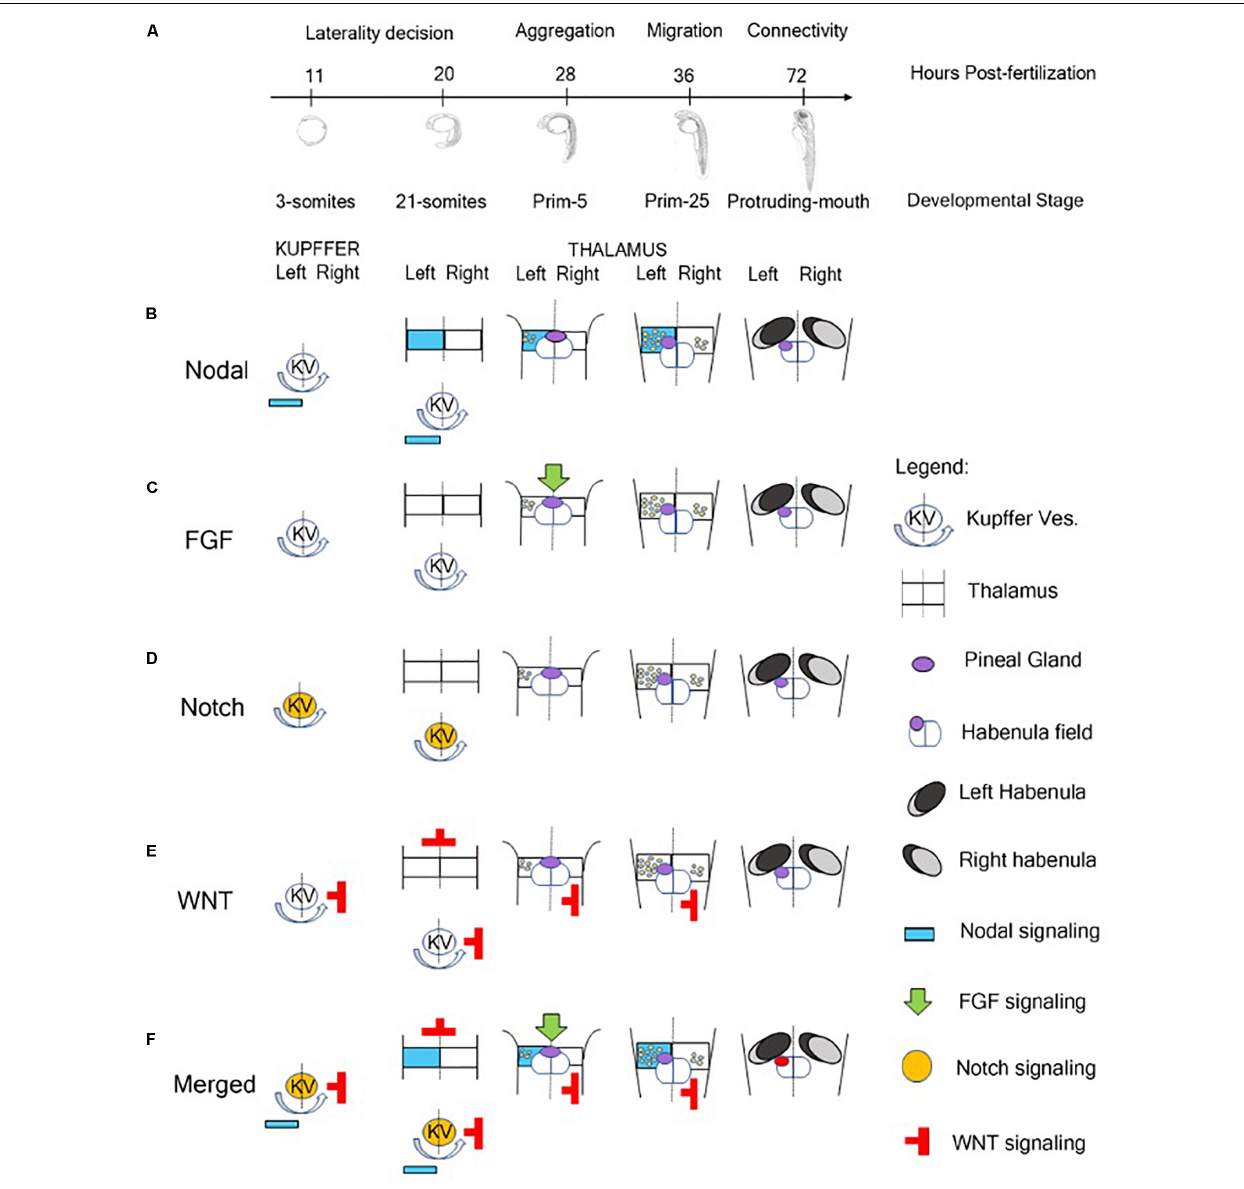
FIGURE 1 | Role of signaling pathway in the Generation of Neuroanatomical Asymmetry in zebrafish. (A) Timeline of developmental stages involved in the epithalamic lateralization in zebrafish. (B) Nodal signaling influences left-right asymmetry starting from 3-somites stage in which Kupffer’s Vesicle contributes to the positioning of Nodal-related genes on the left side of zebrafish embryo (Raya et al., 2003). At 28 hpf, with the aggregation of the symmetric parapineal cells on the midline of epithalamus, the forming pineal complex becomes asymmetric with the migration of parapineal cells in the left side of the brain where Nodal-related genes contribute to the differentiation of left-sided habenular nuclei (Concha et al., 2000; Long et al., 2003; Carl et al., 2007; Inbal et al., 2007; Snelson and Gamse, 2009; Roussigné et al., 2012; Duboc et al., 2015). During later development, Nodal signaling is also involved in the generation of connectivity of epithalamic structures (Hüsken et al., 2014). (C) At 28 hpf, FGF signaling plays a role in breaking the symmetry of the brain contributing to the positioning of Nodal-related genes on the left side of the embryo (Neugebauer and Yost, 2014). (D) Notch pathway is involved in the control of cilia length of Kupffer’s Vesicle responsible for breaking the initial symmetry generating a directional fluid flow from the Kuppfer’s Vesicle to the left side of the zebrafish embryo and to positioning Nodal signaling molecules on the left side (Hashimoto et al., 2004; Gourronc et al., 2007; Hojo et al., 2007). (E) The Wnt/beta-catenin cascade acts in the lateral mesodermal plate before the induction of Nodal pathway components contributing to the establishment of left-right asymmetry of the brain in three different developmental stages of zebrafish: late gastrulation, somitogenesis and during epithalamic development (Carl et al., 2007; Hüsken and Carl, 2013). (F) In brief, Notch signaling influences the direction of fluid flow originated by ciliated cells of Kupffer’s vesicle and contributes to the positioning of Nodal-related genes on the left side of zebrafish embryo and of Nodal inhibitors and WNT signaling molecules on the right. At later stage, FGF signaling breaks the symmetry of the epithalamic structures and, in synergy with Nodal pathway, plays a role in the establishment of brain asymmetry in zebrafish embryo contributing to the migration of parapineal cells on the left side and to the generation of asymmetric habenular nuclei.